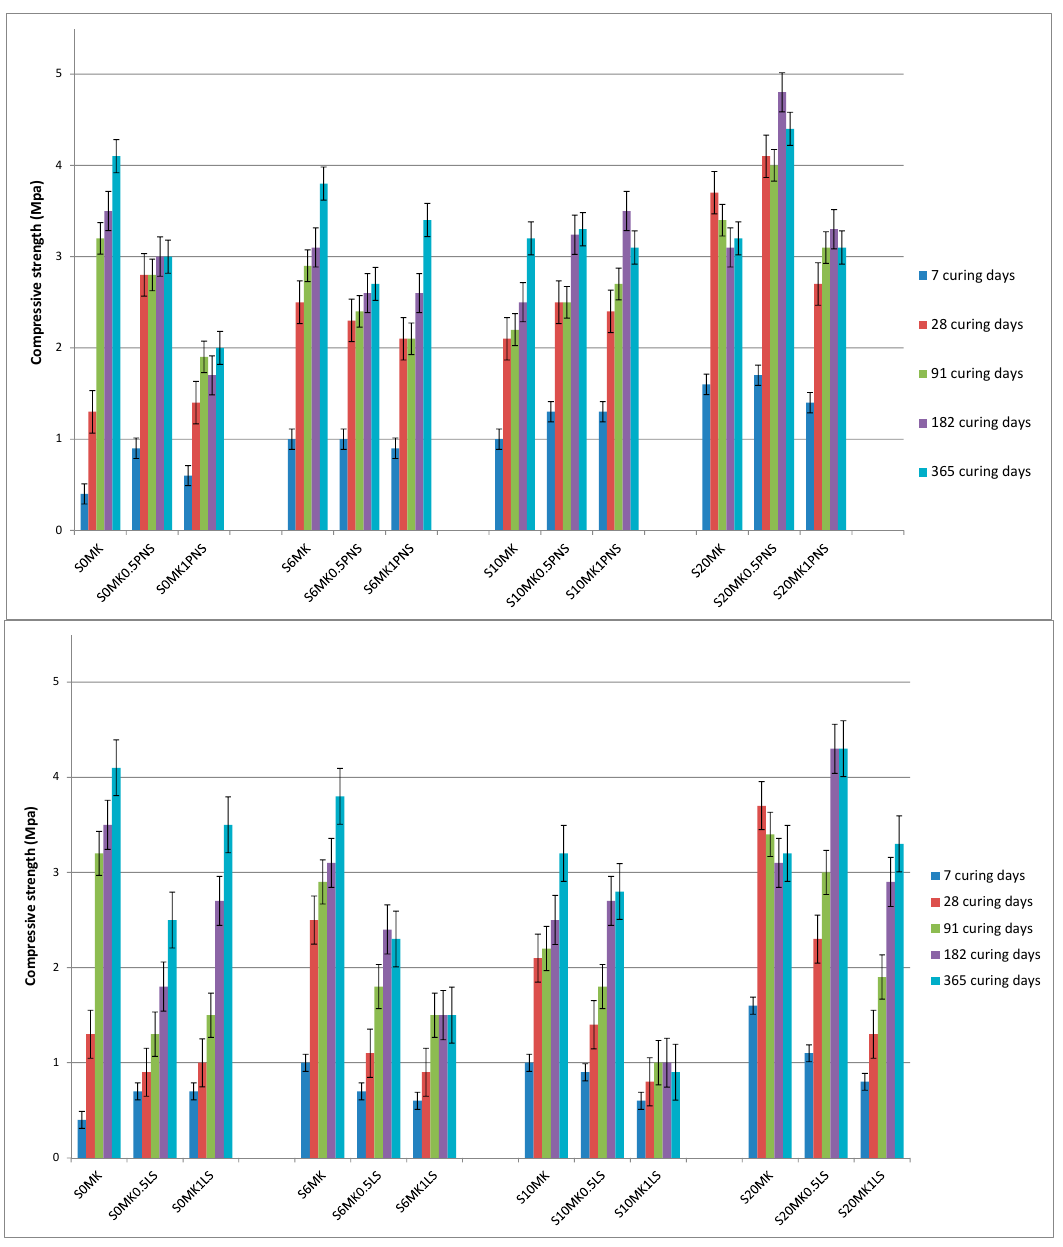
Figure 5. Compressive strength results of the grouts. PNS ( top ); and LS ( bottom ).